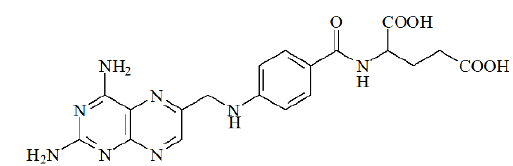
Figure 1. Molecular structure of